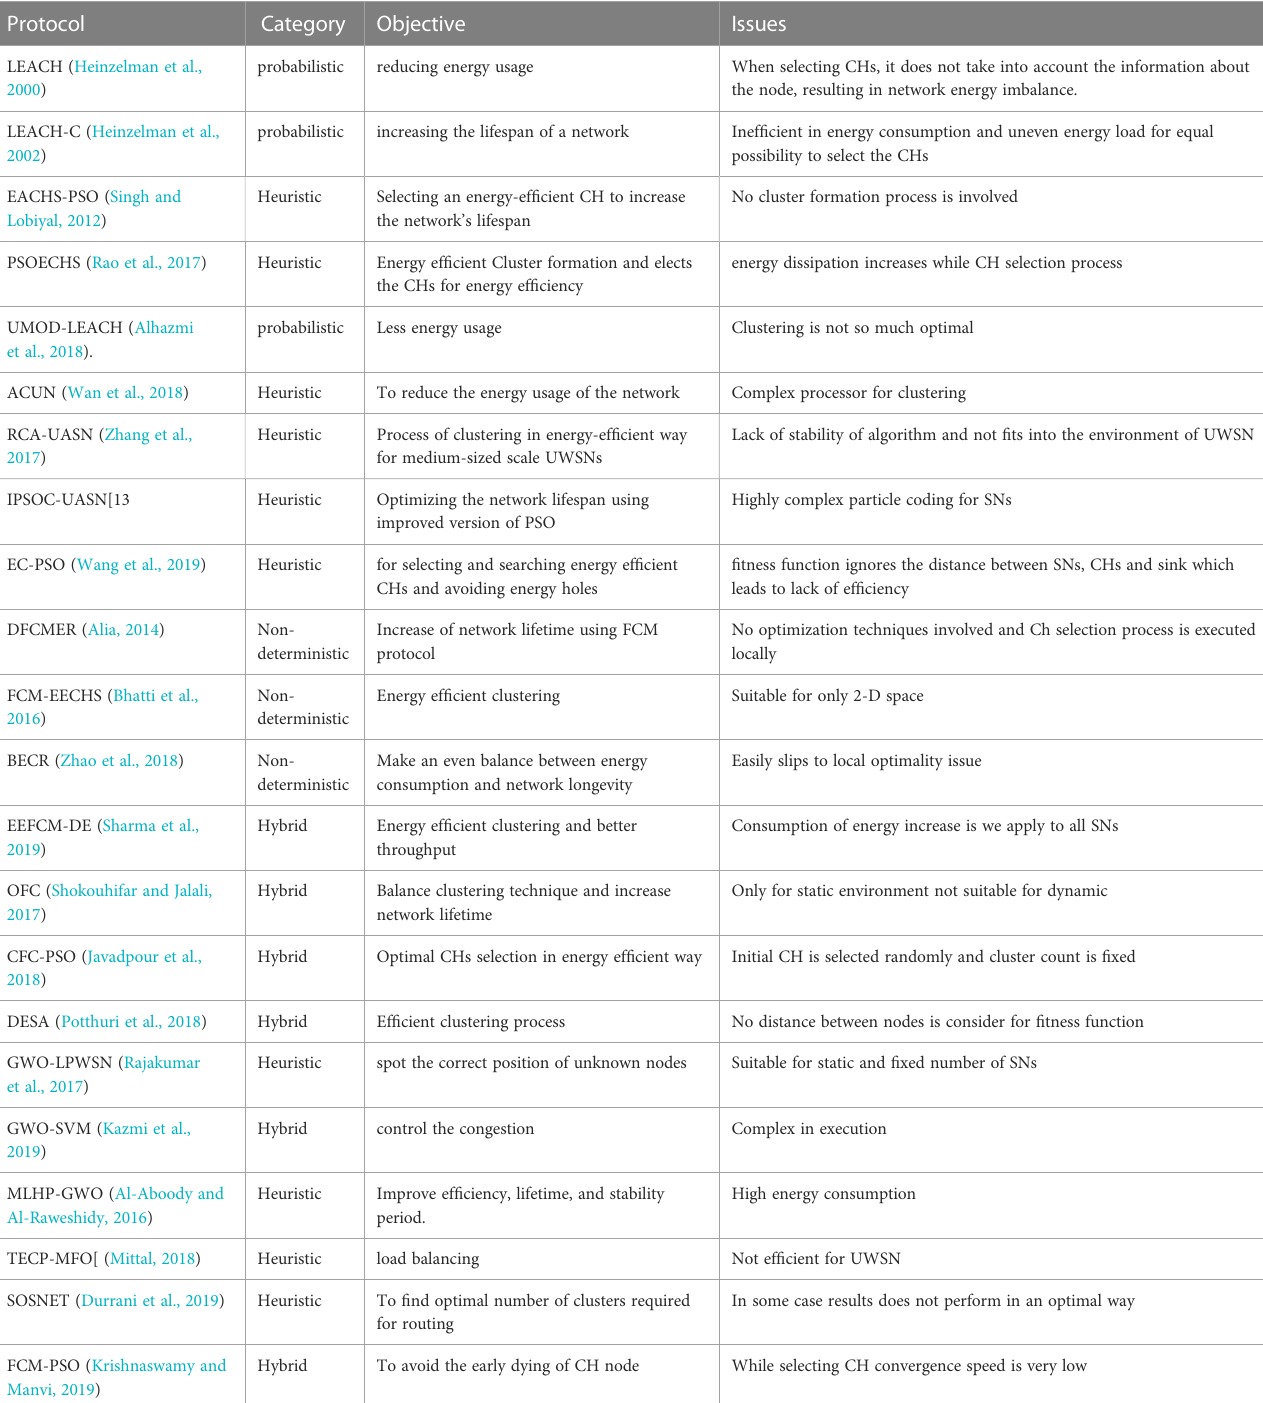
TABLE 1 Comparison of various